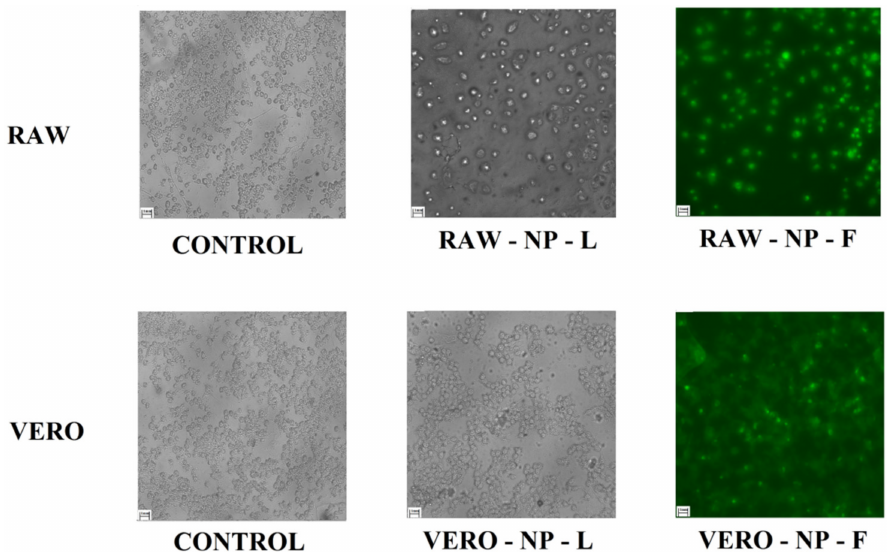
Figure 5. Fluorescent microscopy of different cell lines 24 h after being exposed to stained DETC- loaded nanoparticles. The cell lines RAW and VERO were exposed to DETC nanoparticles stained with FITC to evaluate if nanoparticles can enter inside cells, the scale bar is 0.1 mm/cm.